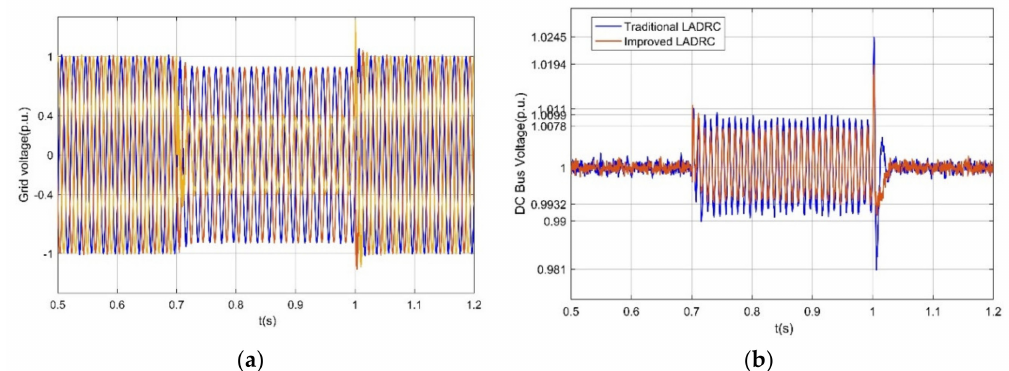
Figure 17. Power network voltage waveform and DC link voltage waveform when the power network voltage drops by 0.6 p.u. asymmetrically: ( a ) Waveform of the power network voltage; ( b ) Waveform of the DC link